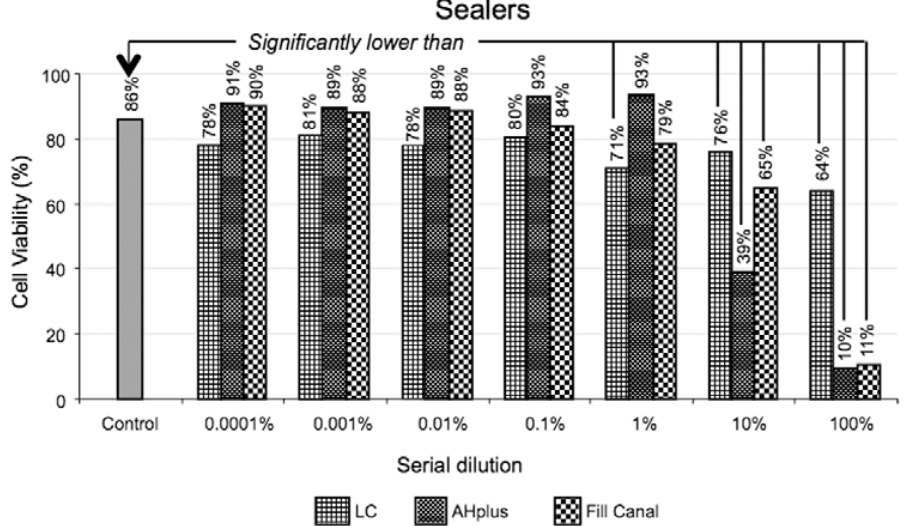
FIGURE 2- Effect of 24 h crude (100%) and diluted elutes of the epoxy-resin sealer (AH Plus), zinc oxide-eugenol sealer (Fill Canal), and commercial calcium hydroxide-based paste (L&C) on THP1 cells by trypan blue dye exclusion assay expressed as percentage of viable cells in control and test groups. Each bar represents the